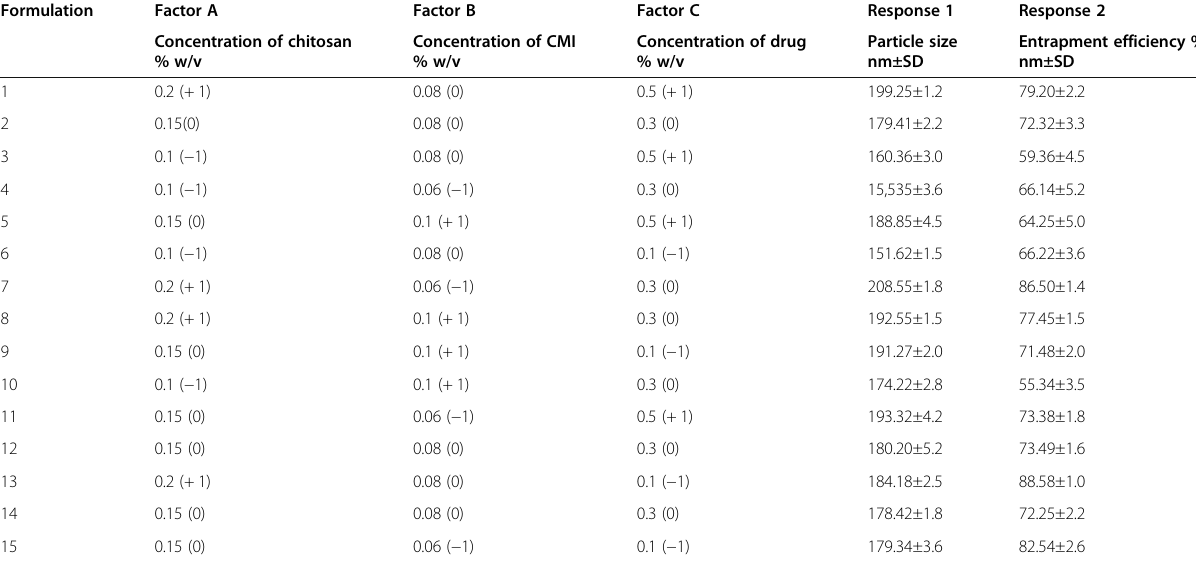
Table 2 Experimental runs for Box-Behnken design